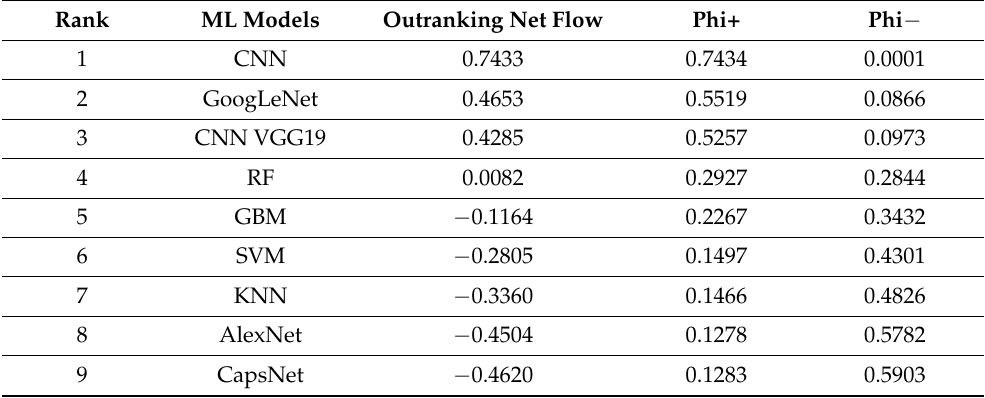
Table 6. Validation results with fuzzy